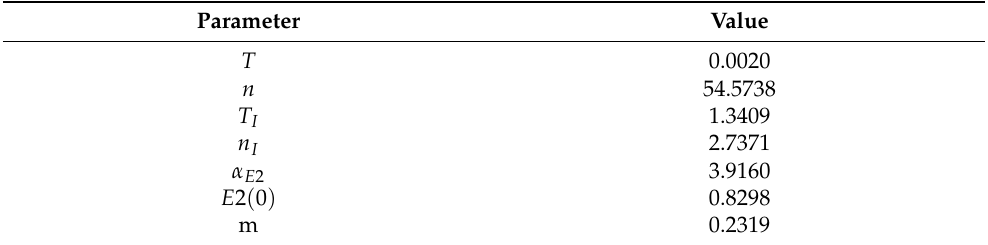
Table 2. Optimised parameter values for Equation (1).